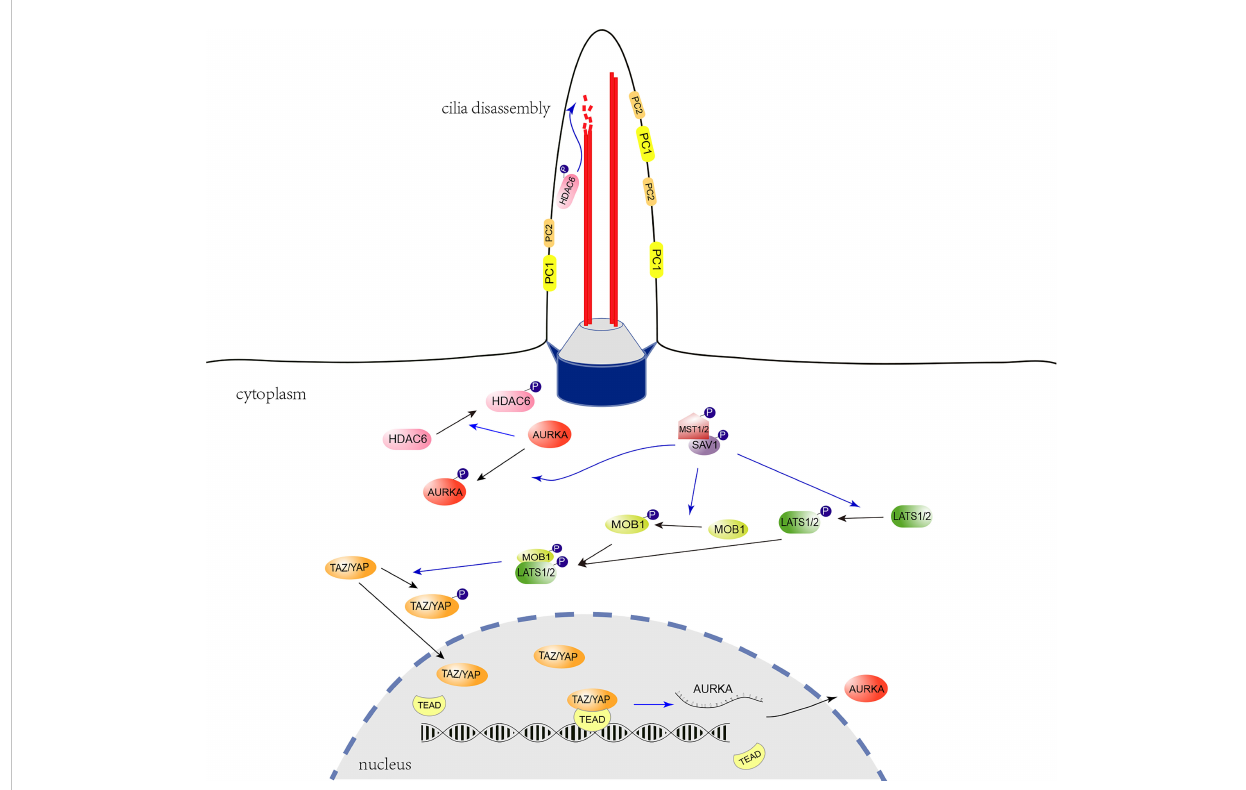
FIGURE 5 Regulatory role of the Hippo signaling pathway in ciliogenesis. The cilium is indicated with two microtubule doublets (red robs) bounded with the ciliary membrane, the transition zone (grey trapezoidal cylinder), and the basal body (blue cylinder) formed with the mother centriole. In the Hippo signaling pathway, Activated LATS1/2 phosphorylate and inhibit the translocation of YAP/TAZ from the cytoplasm to the nucleus. LATS1/2 is activated by MST1/2 through direct phosphorylation, which is promoted by the scaffold protein, phosphorylated SAV1. The YAP/TAZ act as transcriptional coactivators and interact with the TEAD transcription factor 4 (TEAD 4) to regulate the expression of Aurka . The AURKA phosphorylates and activates the tubulin deacetylase HDAC6 to promote ciliary disassembly. In the absence of PC1, decreased MST1 and LATS1 may promote YAP/TAZ nuclear translocation, facilitate Aurka transcription and subsequent ciliary disassembly. The blue-arrow lines indicate positive